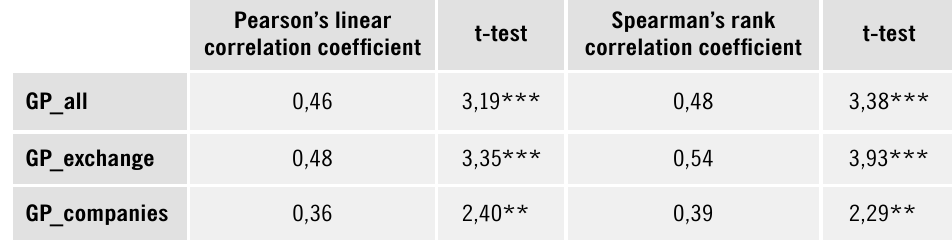
Table 5. Values of correlations’ coefficients between SDI and GP _ all, GP _ exchange and GP _ companies Pearson’s linear Spearman’s rank t-test correlation coefficient correlation